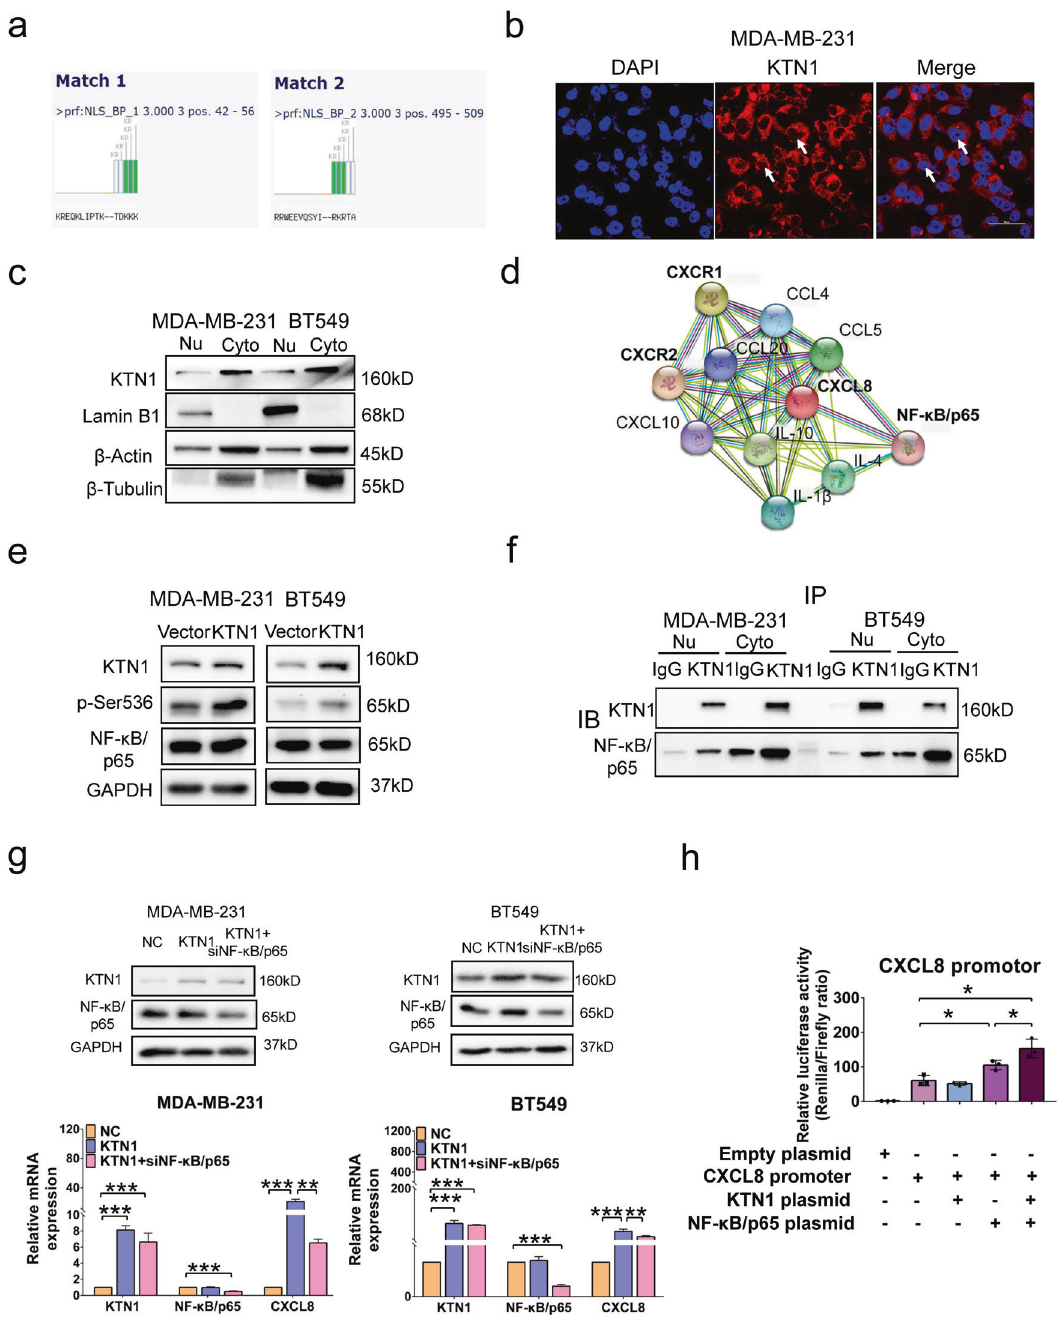
Fig. 4 KTN1 regulated CXCL8 mRNA via phosphorylating NF- κ B/p65 in TNBC cells. a Myhits bioinformatics database (https://myhits.sib.swiss/ cgi-bin/motif_scan) analysis of functional domains of KTN1. b KTN1 were localized in the nucleus of MDA-MB-231 cells by laser confocal microscopy. c Cytoplasm and nuclei protein separation determined with a Western blot assay. Lamin B1 and β -Tubulin were used as nuclear and cytoplasmic biomarkers, β -Actin was the whole-cell biomarker. d String bioinformatics database (https://string-db.org/)analysis of the functional interaction of CXCL8 and NF- κ B/p65. e Western blot analysis of protein expression on KTN1, phosphorylated NF- κ B/p65 (Ser536), NF- κ B/p65 in MDA-MB-231 and BT549 cells transfected with minicircle KTN1 plasmid compared with control vector plasmid. f NF- κ B/p65 was veri fi ed to be the interacting partner of KTN1 by Co-IP followed with Western blot assay. g Western blot and qRT-PCR analysis of mRNA expression of KTN1, NF- κ B/ p65, and CXCL8 in MDA-MB-231 and BT549 cells with KTN1 overexpression or NF- κ B/p65 depletion vectors. h Luciferase activity of CXCL8 gene promoter reporters in 293 T cells transfected with KTN1 or NF- κ B/p65 plasmid. Each experiment was performed in triplicate and data a represented as mean ± s.d. One-Way ANOVA and Dunnett ’ s multiple comparison test were used to analyze the data (* P < 0.05, ** P < 0.01, *** P <